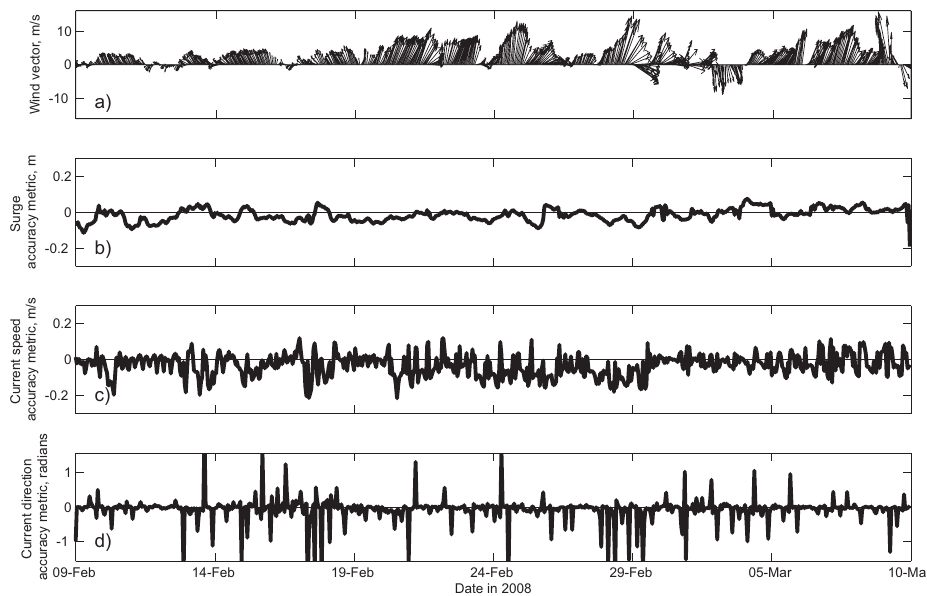
Fig. 4. Time-varying accuracy at Site B. (a) Wind vectors at this location and differential accuracy metric ( DA ) for (b) the surge, (c) the current speed and (d) the current direction. Negative values indicate the Charnock relation is performing with higher accuracy at this site than the COARE bulk wind stress formula and vice versa for positive